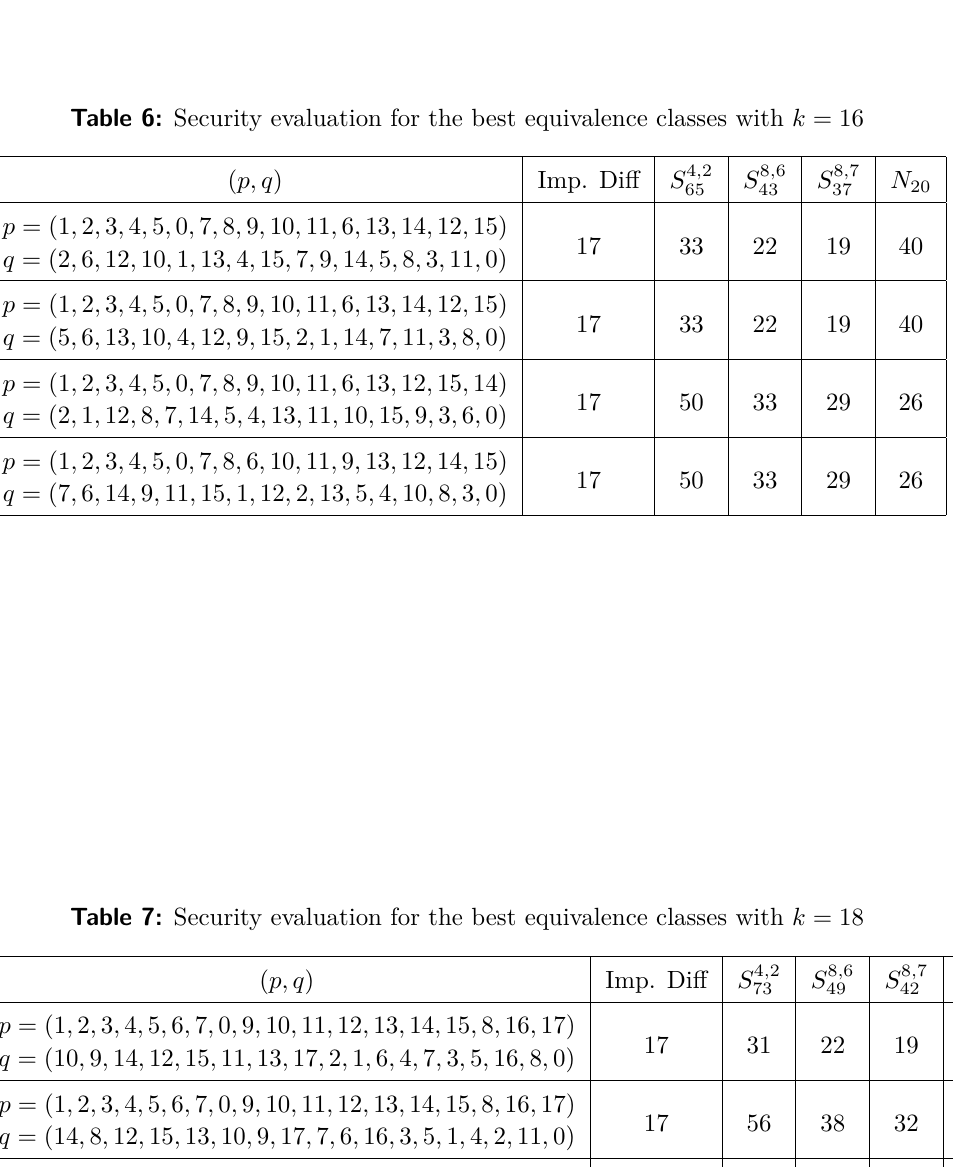
S 8 , 6 S 8 , 7 N 20 65 43 37